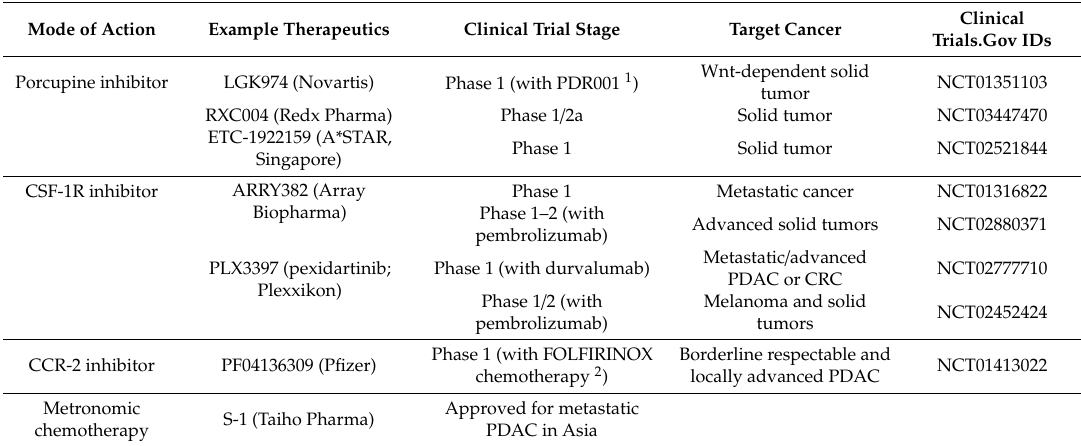
Table 1. Clinical-stage agents with potential activity in panCSC targeting described in the current